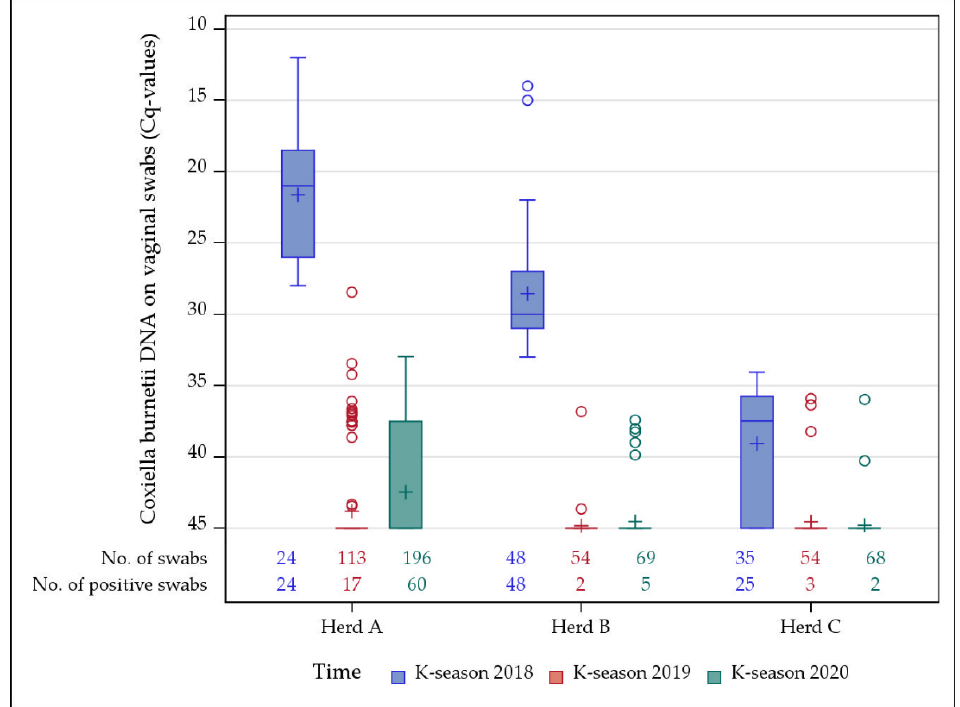
Figure 2. Coxiella burnetii shedding through vaginal route during three (2018–2020) kidding seasons (K-season) in three naturally C. burnetii infected dairy goat herds (A–C) analyzed by qPCR. All goat herds were vaccinated after C. burnetii had been diagnosed in 2018.